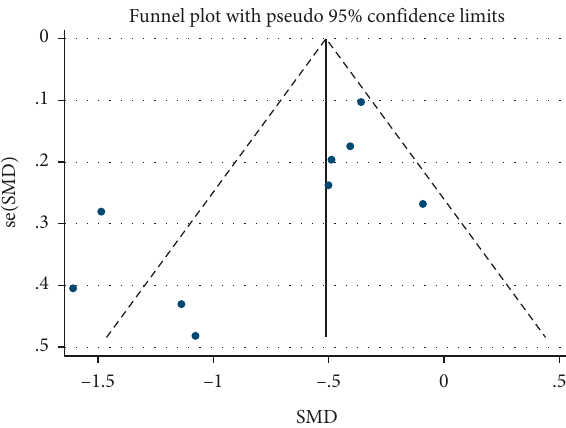
Figure 3: Funnel plot for analyzing publication bias.